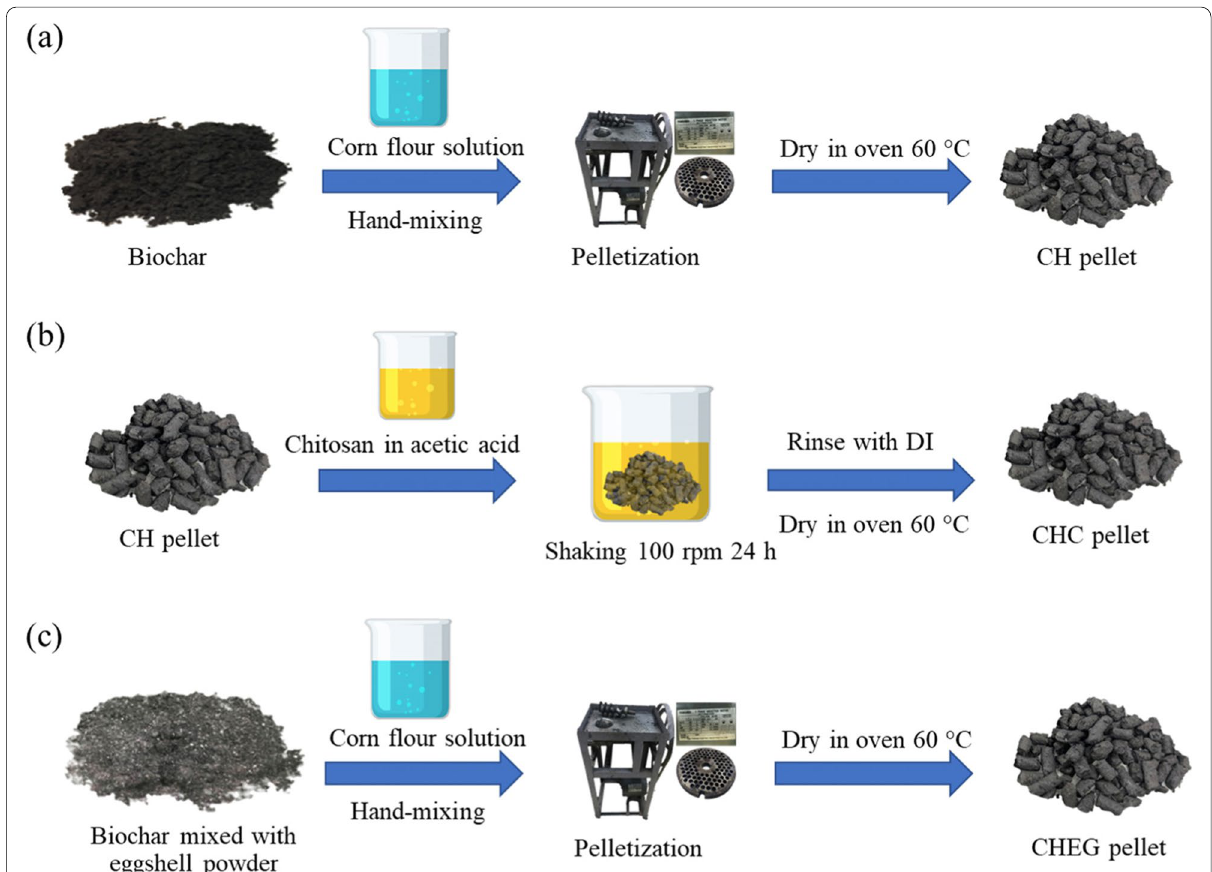
Fig. 1 Diagram of ( a ) coconut husk biochar pelletization and its modification with ( b ) chitosan and ( c ) eggshell